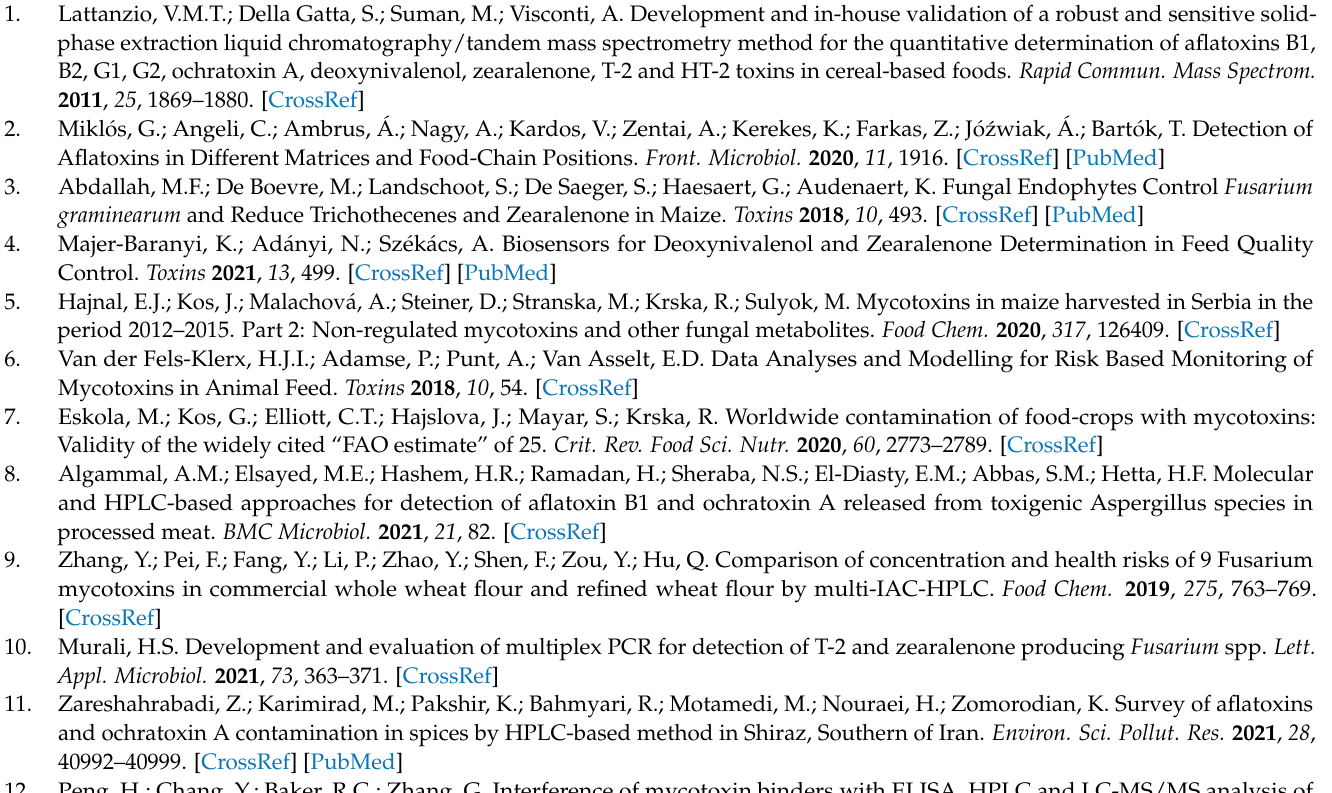
Figure A1. Comparison of different mobile phase toxin chromatograms: ( a ) Comparison between 0.1% formic acid-acetonitrile (B) and acetonitrile (B); ( b ) Comparison between 0.1% formic acid- methanol (B) and acetonitrile (B); ( c ) Comparison between 0.1% formic acid (A) and water (A) .